Question: Describe this figure in one sentence.
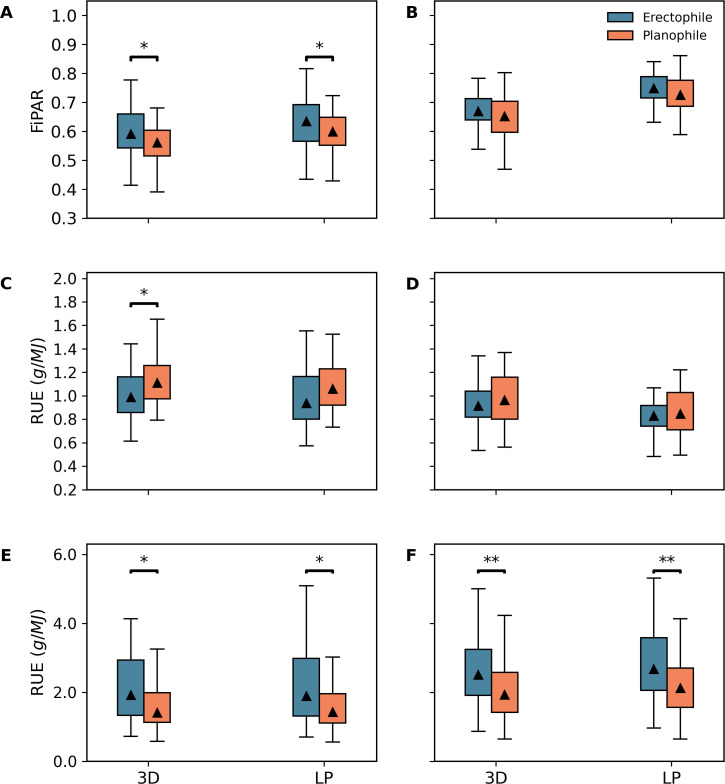
Answer: The FiPAR and RUE responses between two architectural phenotypes under 3D and LP80 methods. FiPAR (A, B) and RUE (C, D) were estimated at the heading in 2022 (A, C) and booting stage in 2023 (B, D) , respectively. Additionally, RUE is calculated for the period between the heading and anthesis stage in 2022 (E) and between the booting and anthesis stage in 2023 (F) . ▴ and * refer to the median values and statistically significant differences between the two PA phenotypes, respectively. (* p < 0.05, ** p < 0.01).